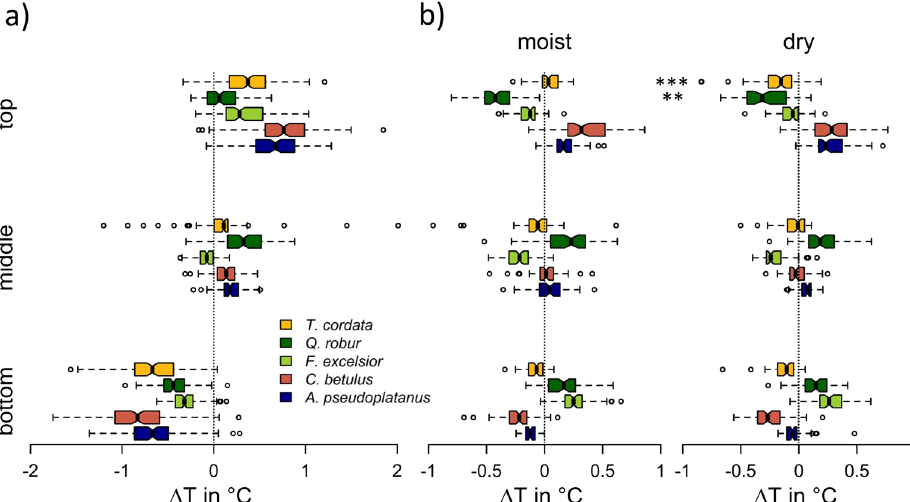
Figure 3. ( a ) Variations in species-specific canopy temperatures (centered per day) across height layers and ( b ) comparison of intraspecific temperature differences (centered per day and height layer) at a certain height layer for the moist and the dry period; asterisks indicate significance of intraspecific differences between the moist and dry period resulting from Tukey-Test (* p > 0.05, ** p > 0.01, *** p > 0.001).